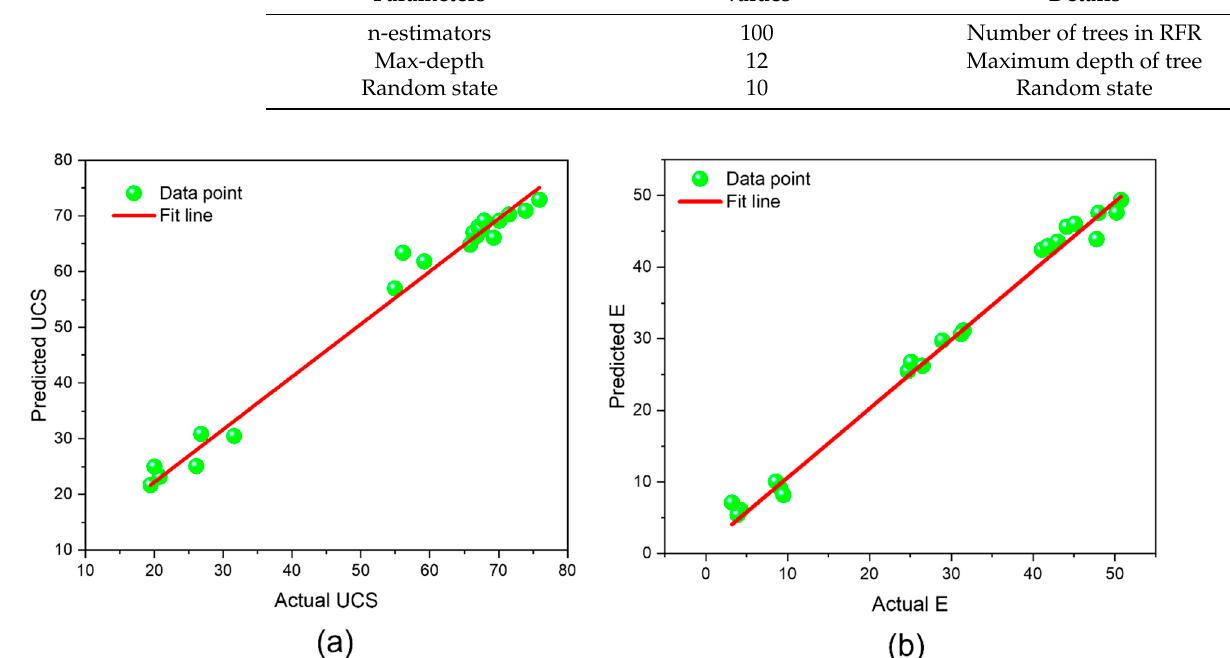
Figure 8. Relationship between the predicted and actual UCS ( a ) and E ( b ) of Egyptian granodiorite using random forest technique.